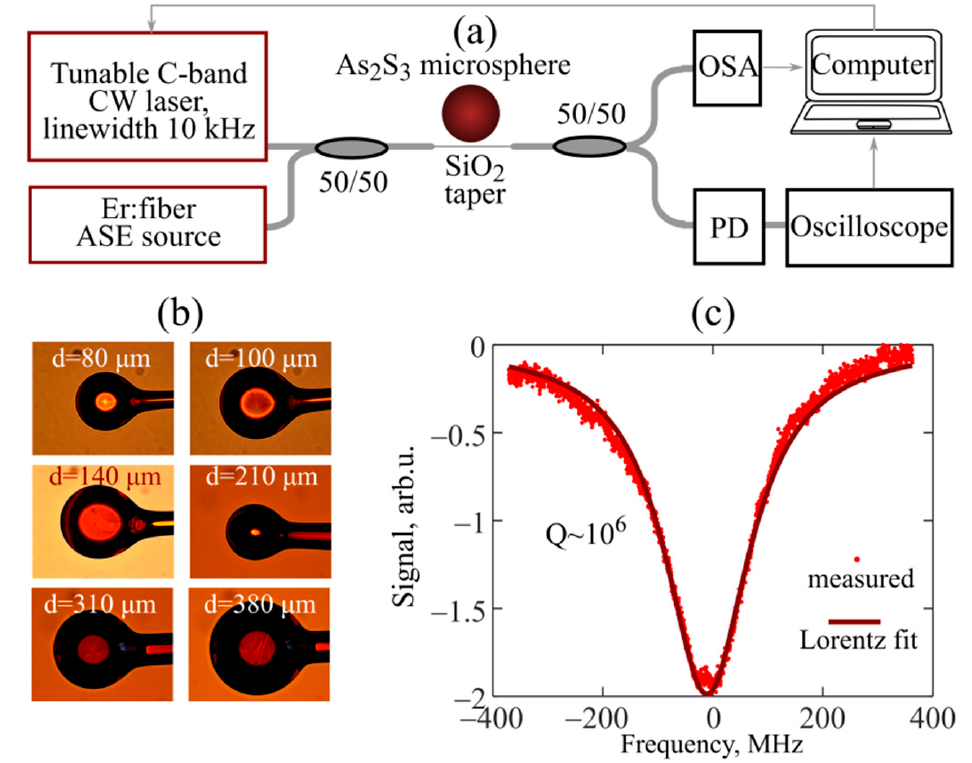
Figure 1. ( a ) Simplified scheme of the experimental setup; CW–continuous wave, ASE–amplified spontaneous emission, OSA–optical spectrum analyzer, PD–photodetector. ( b ) Images of experi- mental As 2 S 3 chalcogenide glass microspheres obtained with optical microscope (with different magnification). ( c ) Measured resonance dip and its Lorentz fit demonstrating Q ‐ factor.